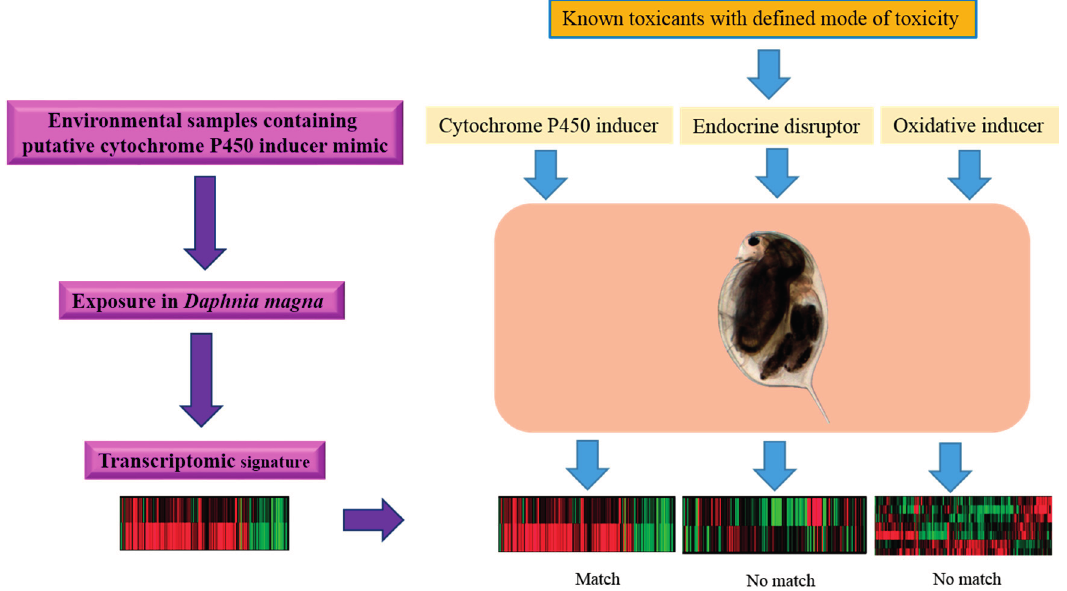
Figure 3. A scheme illustrating the utility of gene expression signatures to explore the possible mode of toxicity of an unknown environmental toxicant in an aquatic model organism ( Daphnia